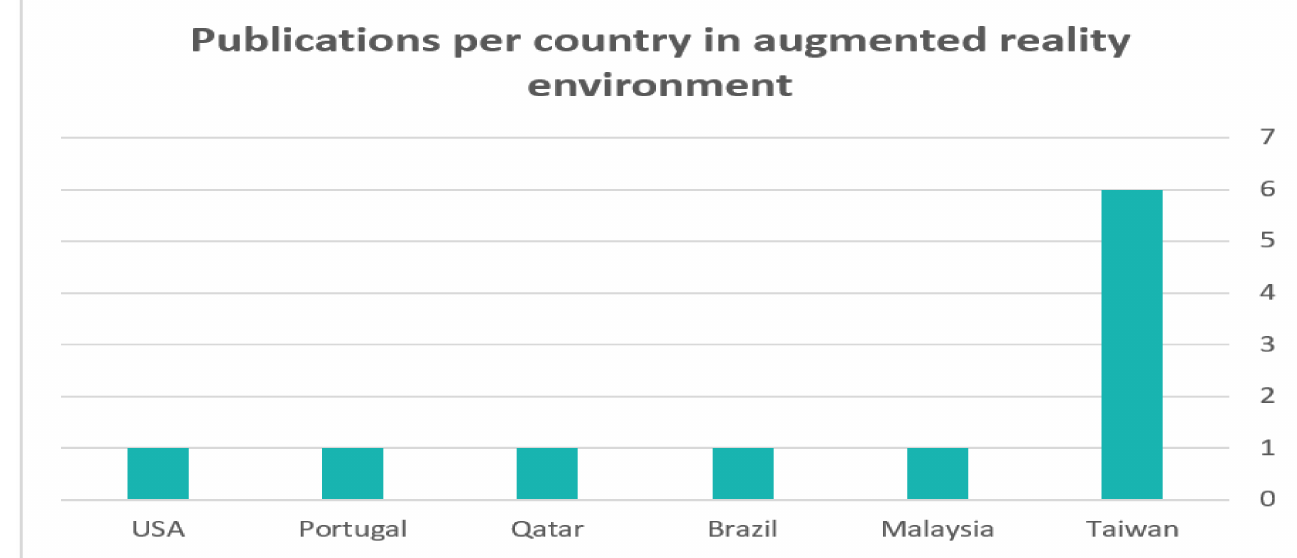
Figure 13. Publications per country in augmented reality